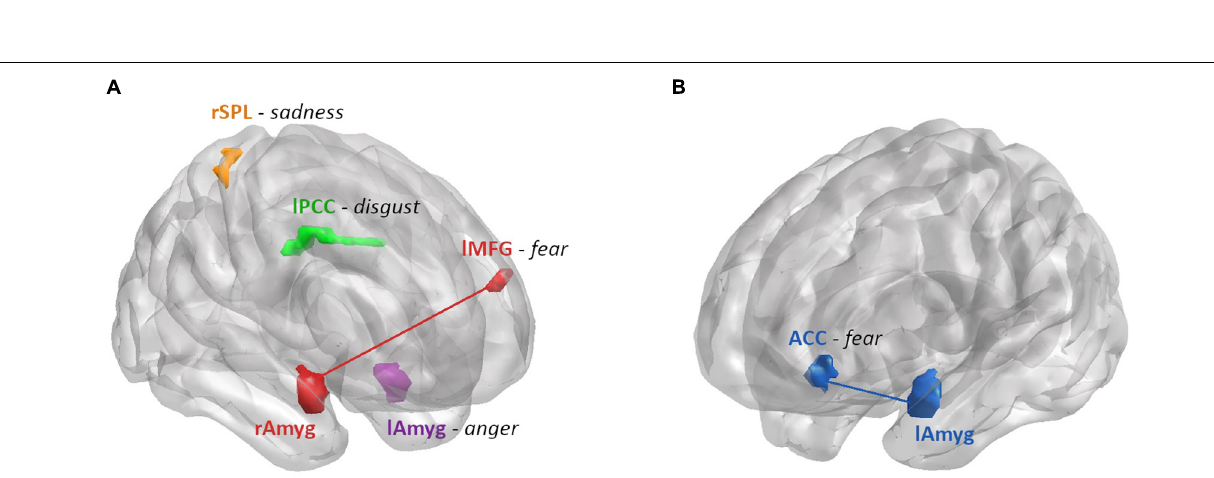
Frontiers in Behavioral Neuroscience |